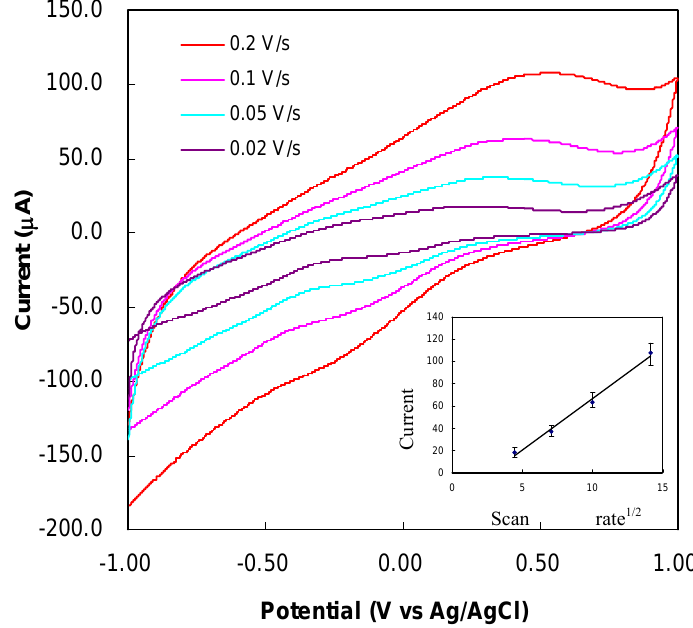
Figure 6. Cyclic voltammograms for cholesterol bioprobe at 300 mg/dL concentration with different scan rates. Inset: Peak current (oxidation peaks) as a function of the square root of scan rate. The error bars indicates the variation from five independent